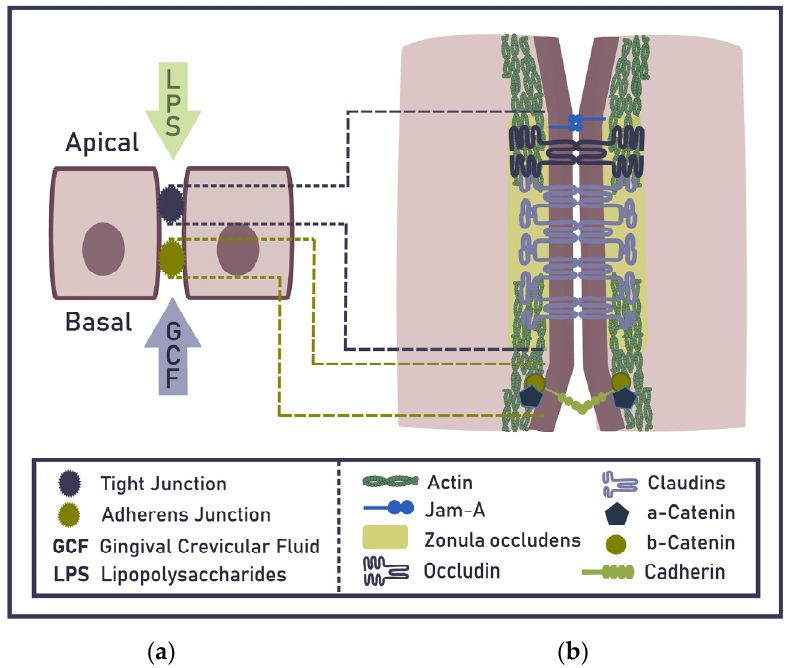
Figure 1. Diagrammatic representation of gingival epithelial barrier: ( a ) tight junctions (TJs) and adherens junctions providing a barrier function to the epithelium, sealing the paracellular space and the flux of gingival crevicular fluid (GCF) and the deposition of lipopolysaccharide (LPS); ( b ) a detailed scheme of TJ consisting of a major transmembrane proteins junction adhesion molecule— A (JAM-A), zonula occludens (ZO), occludins and claudins, cytoplasmic proteins a-catenin and b-catenin complexed with cadherin.